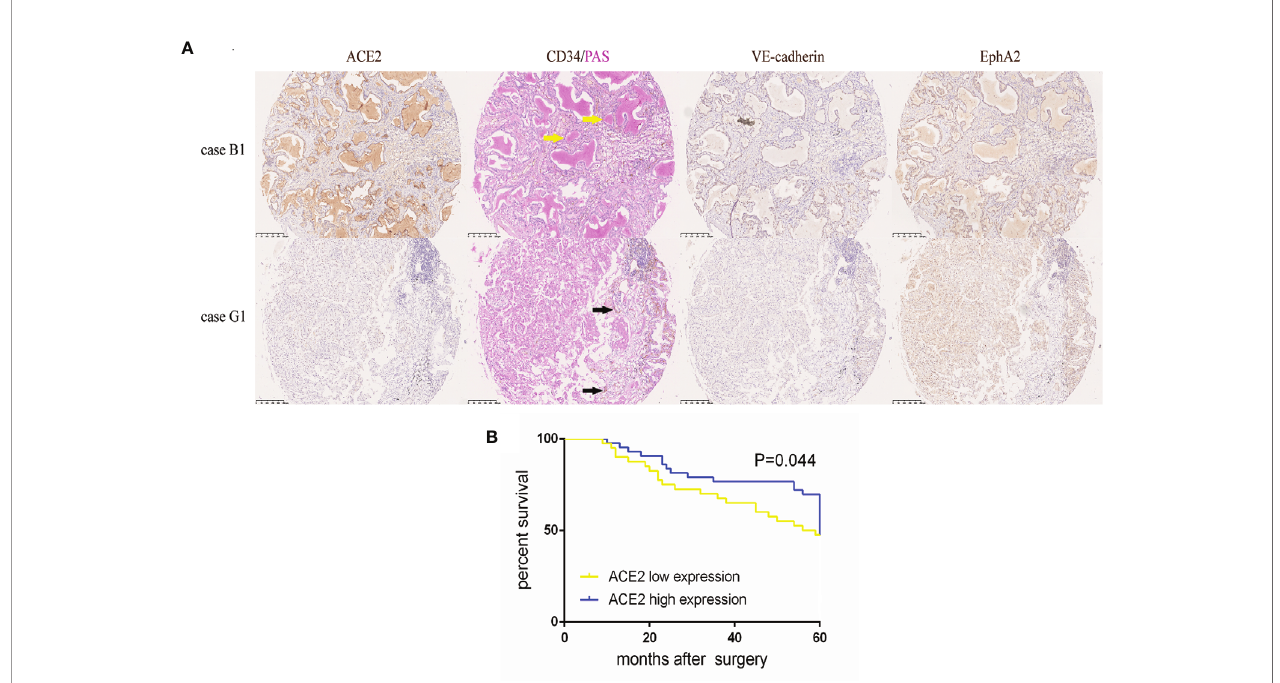
FIGURE 1 | High ACE2 expression was linked to increased VM and better prognosis in NSCLC. (A) Typical image of ACE2, VE-cadherin, EphA2 protein expression and CD34/PAS double staining in TMA tissues. Case B1 had massive CD34 − /PAS + VM (yellow arrows) lined by ACE2, VE-cadherin and EphA2 high expressing tumor cells. Case G1 had abundant CD34 + /PAS − MVs (black arrows) with ACE2, VE-cadherin and EphA2 low expressing tumor cells. (B) Kaplan-Meier analysis of OS in NSCLC patients with ACE2 low or high expression. P =